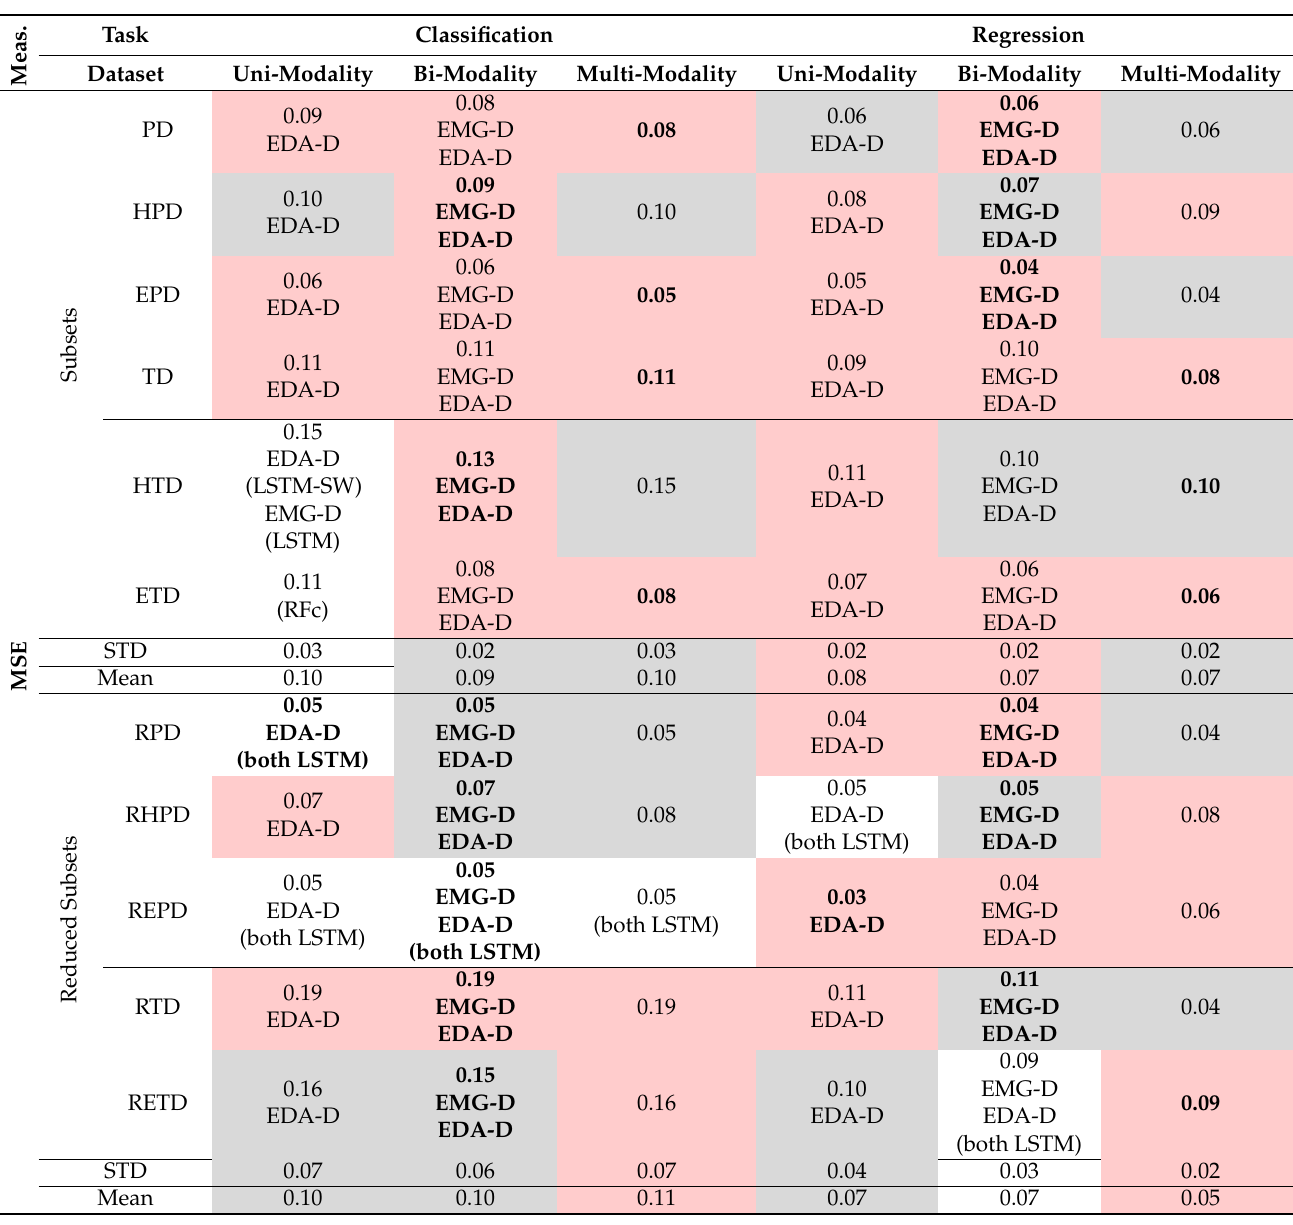
Table 6. Comparison of the best Uni-, Bi-, and Multi-modality models regarding classification and regression tasks with MSE measure. Meas.: Measure. The cells with light grey background indicate the models using LSTM, and cells with pink background indicate the models using LSTM-SW. The bold font indicates the best